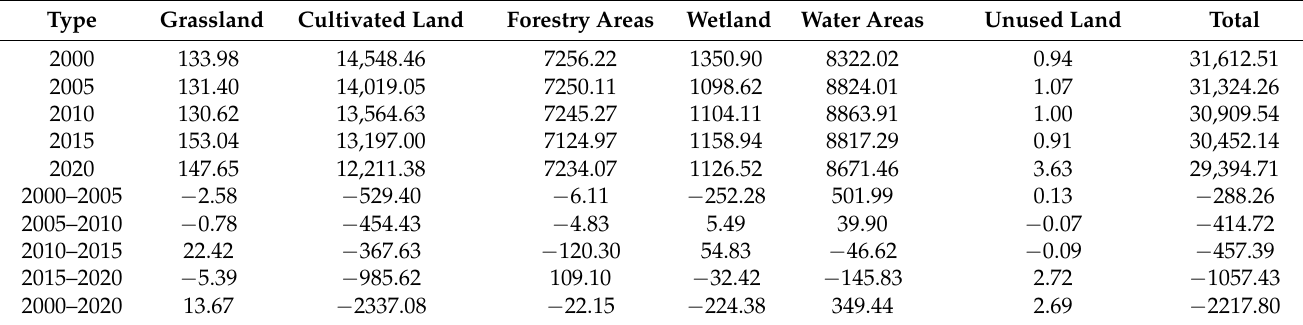
Table 3. ESVs of all land use types in the HAER from 2000 to 2020 (million yuan).